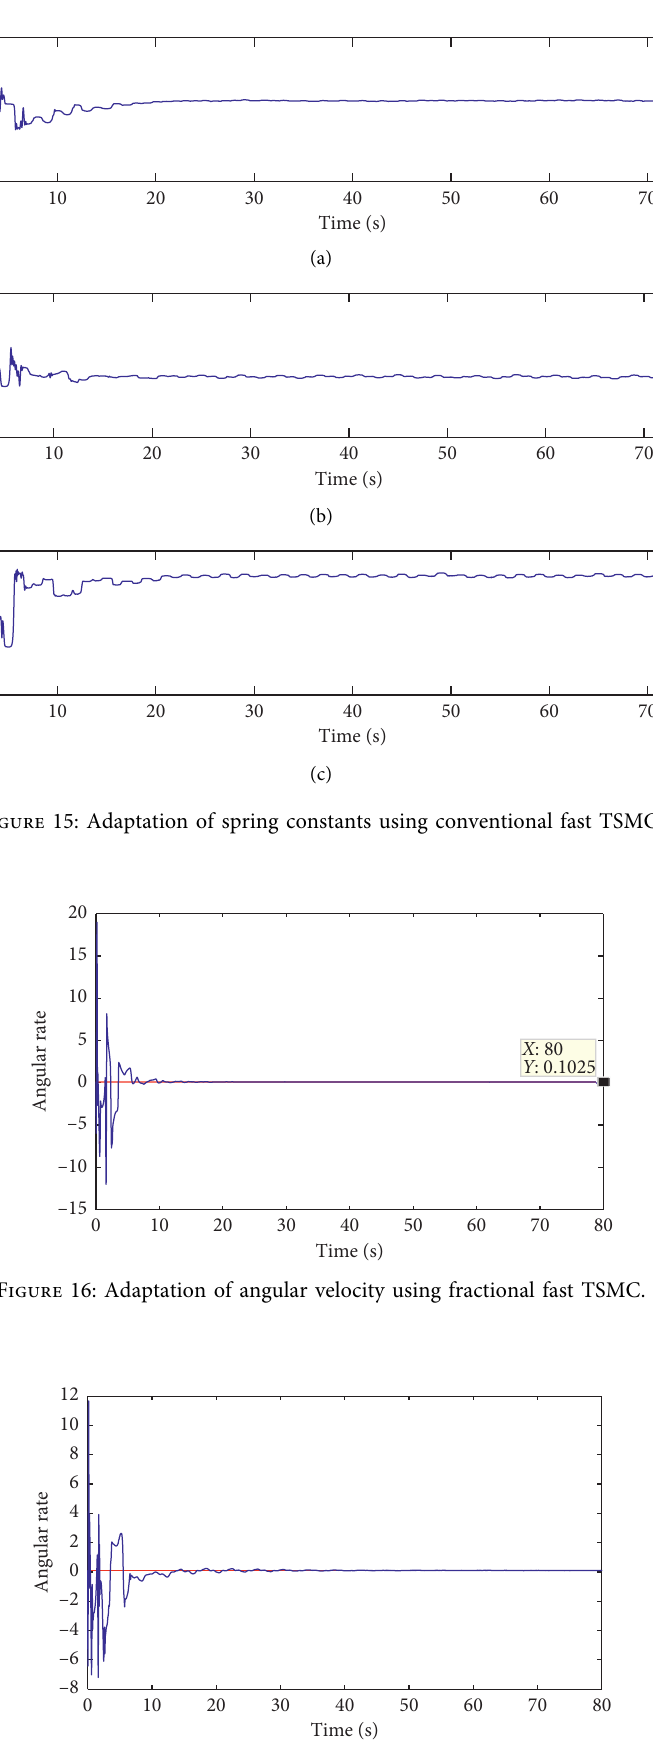
Figure 17: Adaptation of angular velocity using fractional